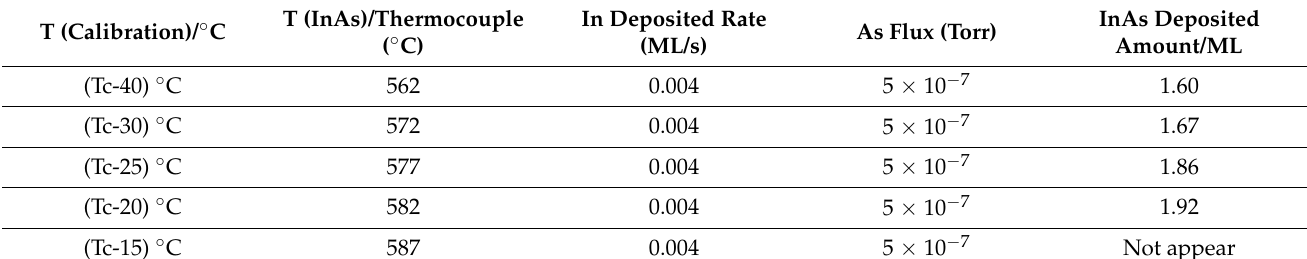
Table 2. Optimization of θ C under various substrate temperatures.